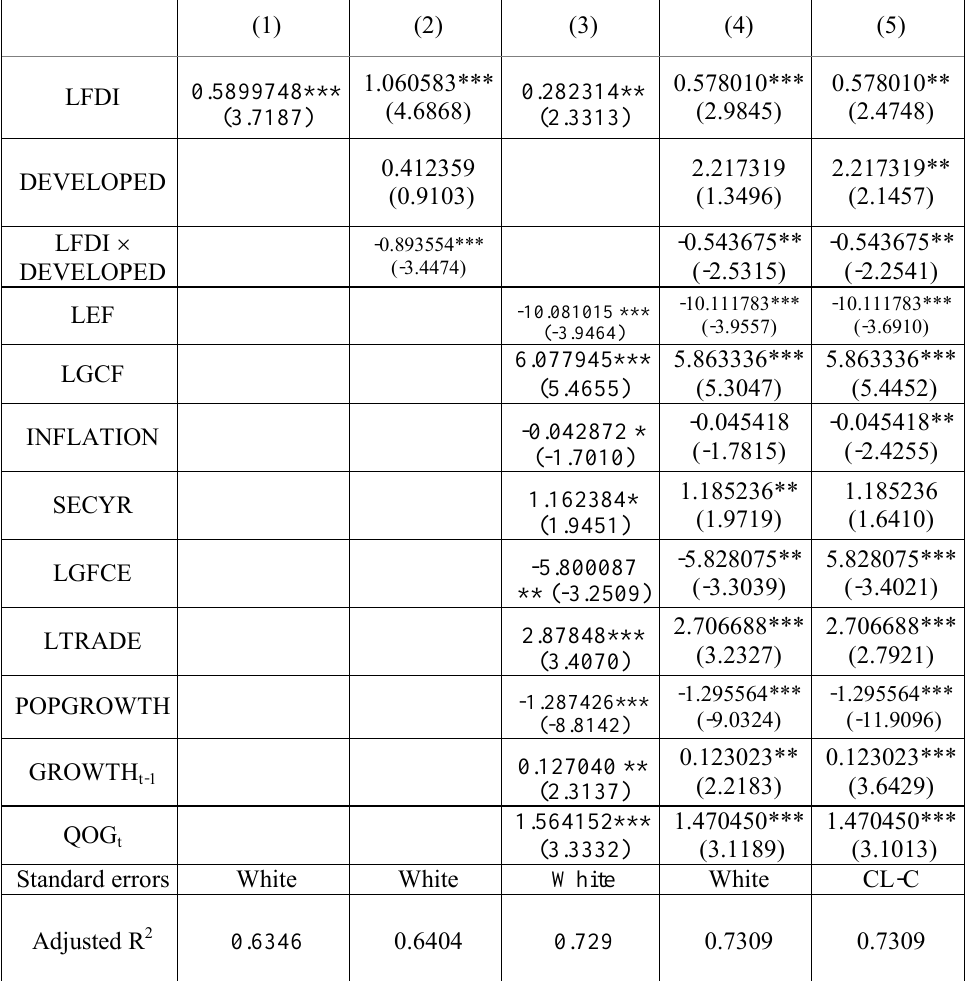
Table 5. relation between per capita GDP growth and (log) net foreign direct investment inflow in developed countries and other